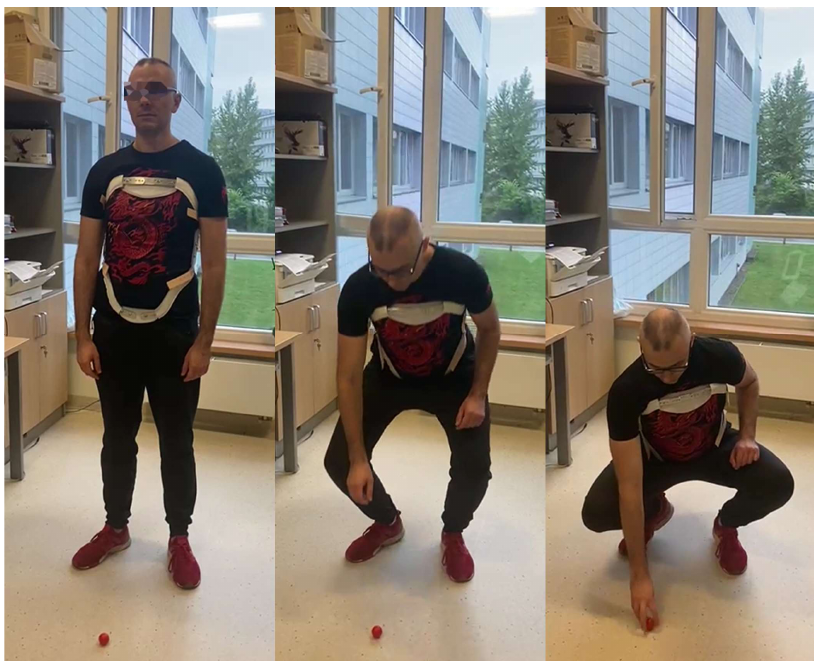
Figure 2. The task of lifting an object from the floor while wearing the Jewett brace.